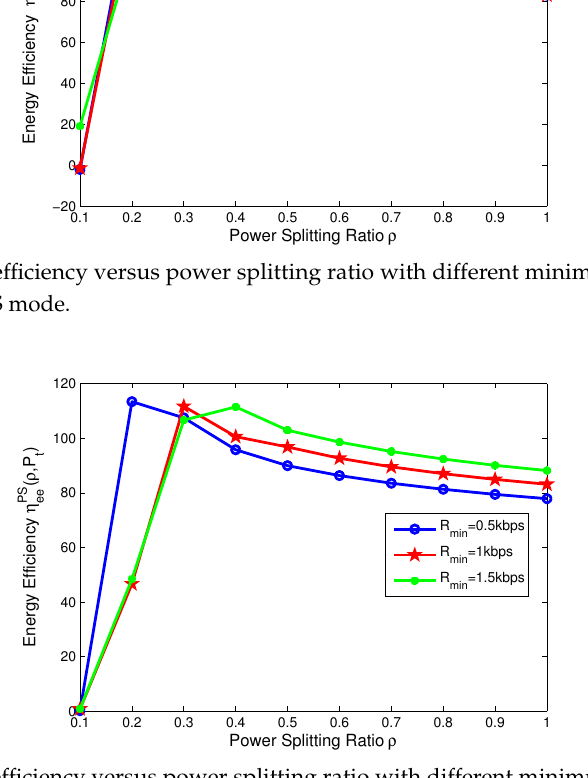
Figure 13. Energy efficiency versus power splitting ratio with different minimum QoS requirements for PS